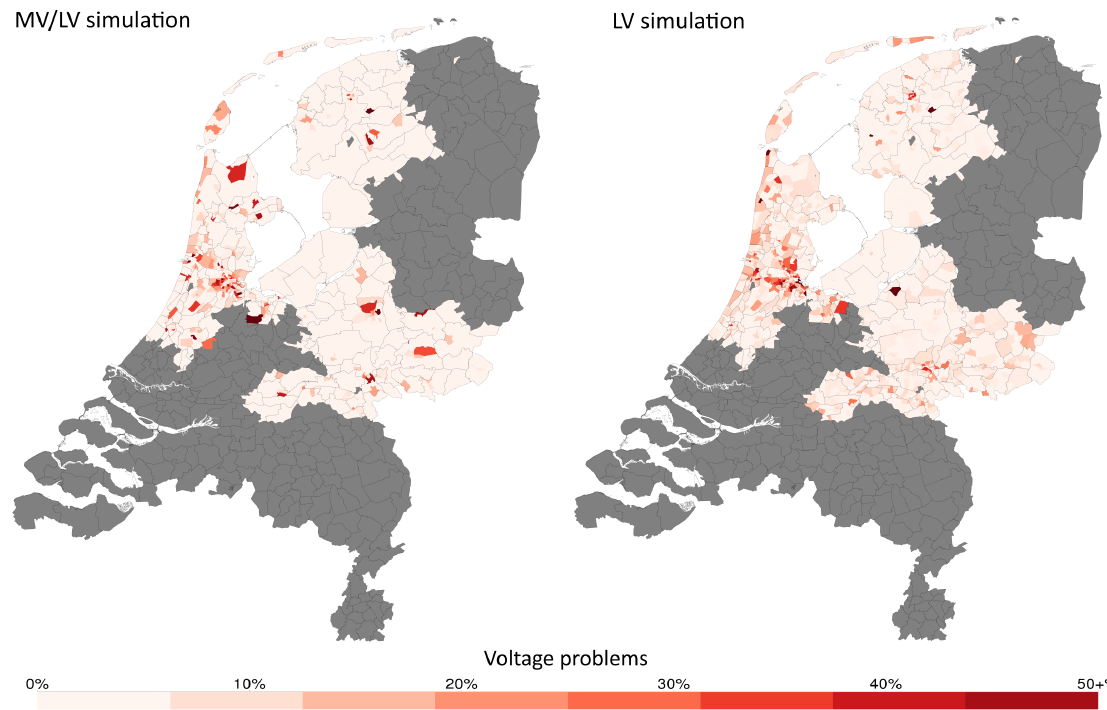
Figure 5. The geographical distribution of customers with voltage problems in the Alliander service area on a postal code level. The area depicted is the entirety of The Netherlands of which Alliander services the non-grey area. This figure has been obtained by computing the power flow of the entire Alliander network with an average load of 1.1 kVA per customer with a power factor of